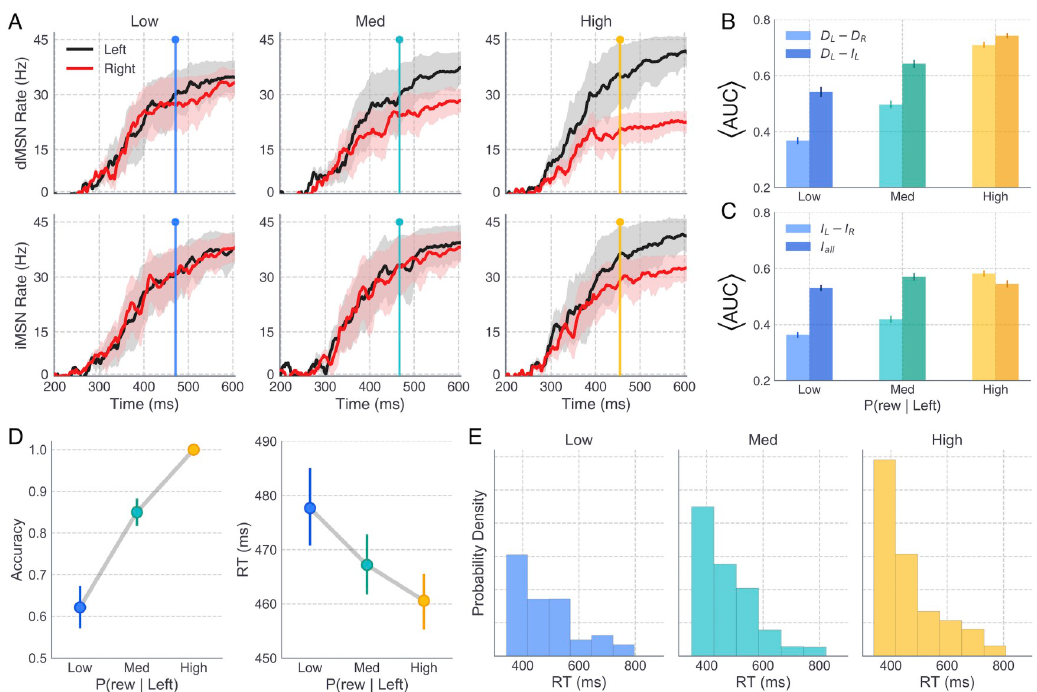
Fig 4. Striatal pathway dynamics and behavioral effects of reward probability in full CBGT network. A: Time courses show the average population firing rates for L (black) and R (red) dMSNs (top) and iMSNs (bottom) over the the trial window. Shaded areas reflect 95% CI. Colored vertical lines depict the average RT in the low (blue), medium (cyan), and high (yellow) reward conditions. B and C: Summary statistics of dMSN and iMSN population firing rates were extracted on each trial and later included as trialwise regressors on parameters of the DDM, allowing specific hypotheses to be tested about the mapping between neural and cognitive mechanisms. In B, lighter colored bars show the difference between dMSN firing rates in the L and R action channels whereas darker colored bars show the difference between dMSN and iMSN firing rates in the L action channel. Each was computed by averaging normalized values of trialwise estimates of the area under the appropriate firing rate curve (AUC); see main text for details. In C, lighter colored bars show the difference between iMSN firing rates in the L and R action channels and darker colored bars show the average iMSN firing rate (combined across left and right channels). Error bars show the bootstrapped 95% CI. D: Average accuracy (probability of choosing L ) and RT ( L choices only) of CBGT choices across levels of reward probability. E: RT distributions for correct choices across levels of reward probability; note that higher reward yields more correct trials. Error bars in B-D show the bootstrapped 95%